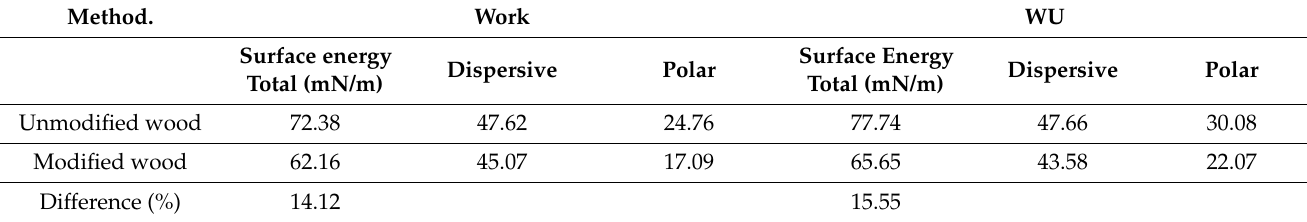
Table 4. The surface energy (mN/m) of unmodified and modified beech wood.